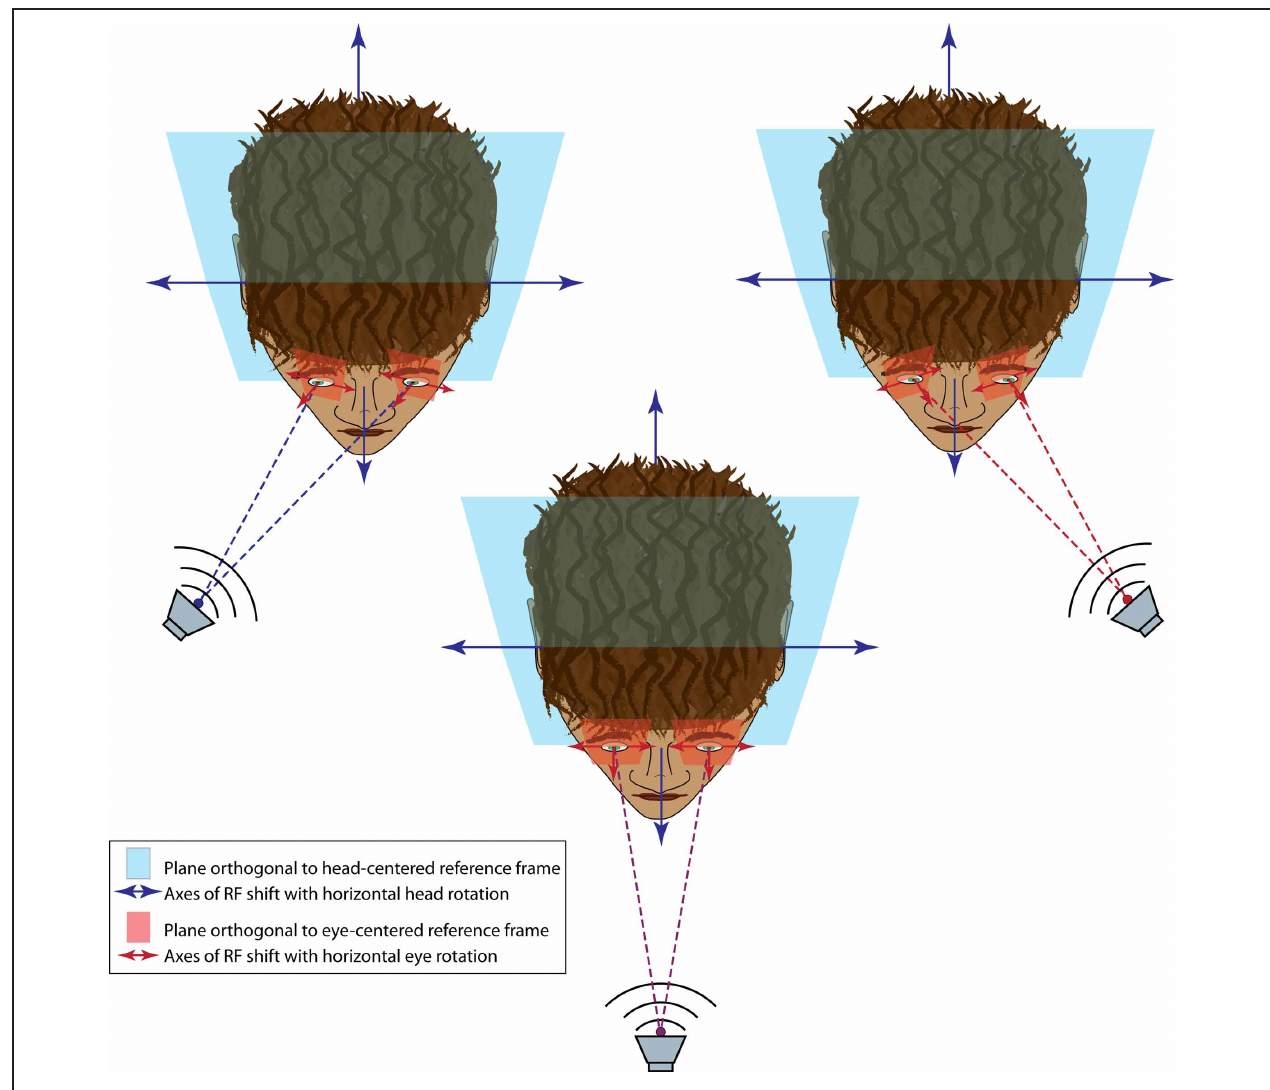
FIGURE 4 | Audiovisual reference frame problem. When an audiovisual target is straight ahead (center panel), the auditory and visual reference frames coincide; that is, a plane orthogonal to the auditory head-centered reference frame (blue field) is parallel to the plane orthogonal to the visual eye-centered reference frame (red field), and both are perpendicular to the audiovisual information source (speaker).